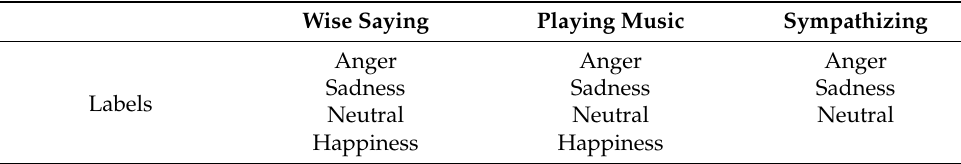
Table 2. Responses corresponding to each of the